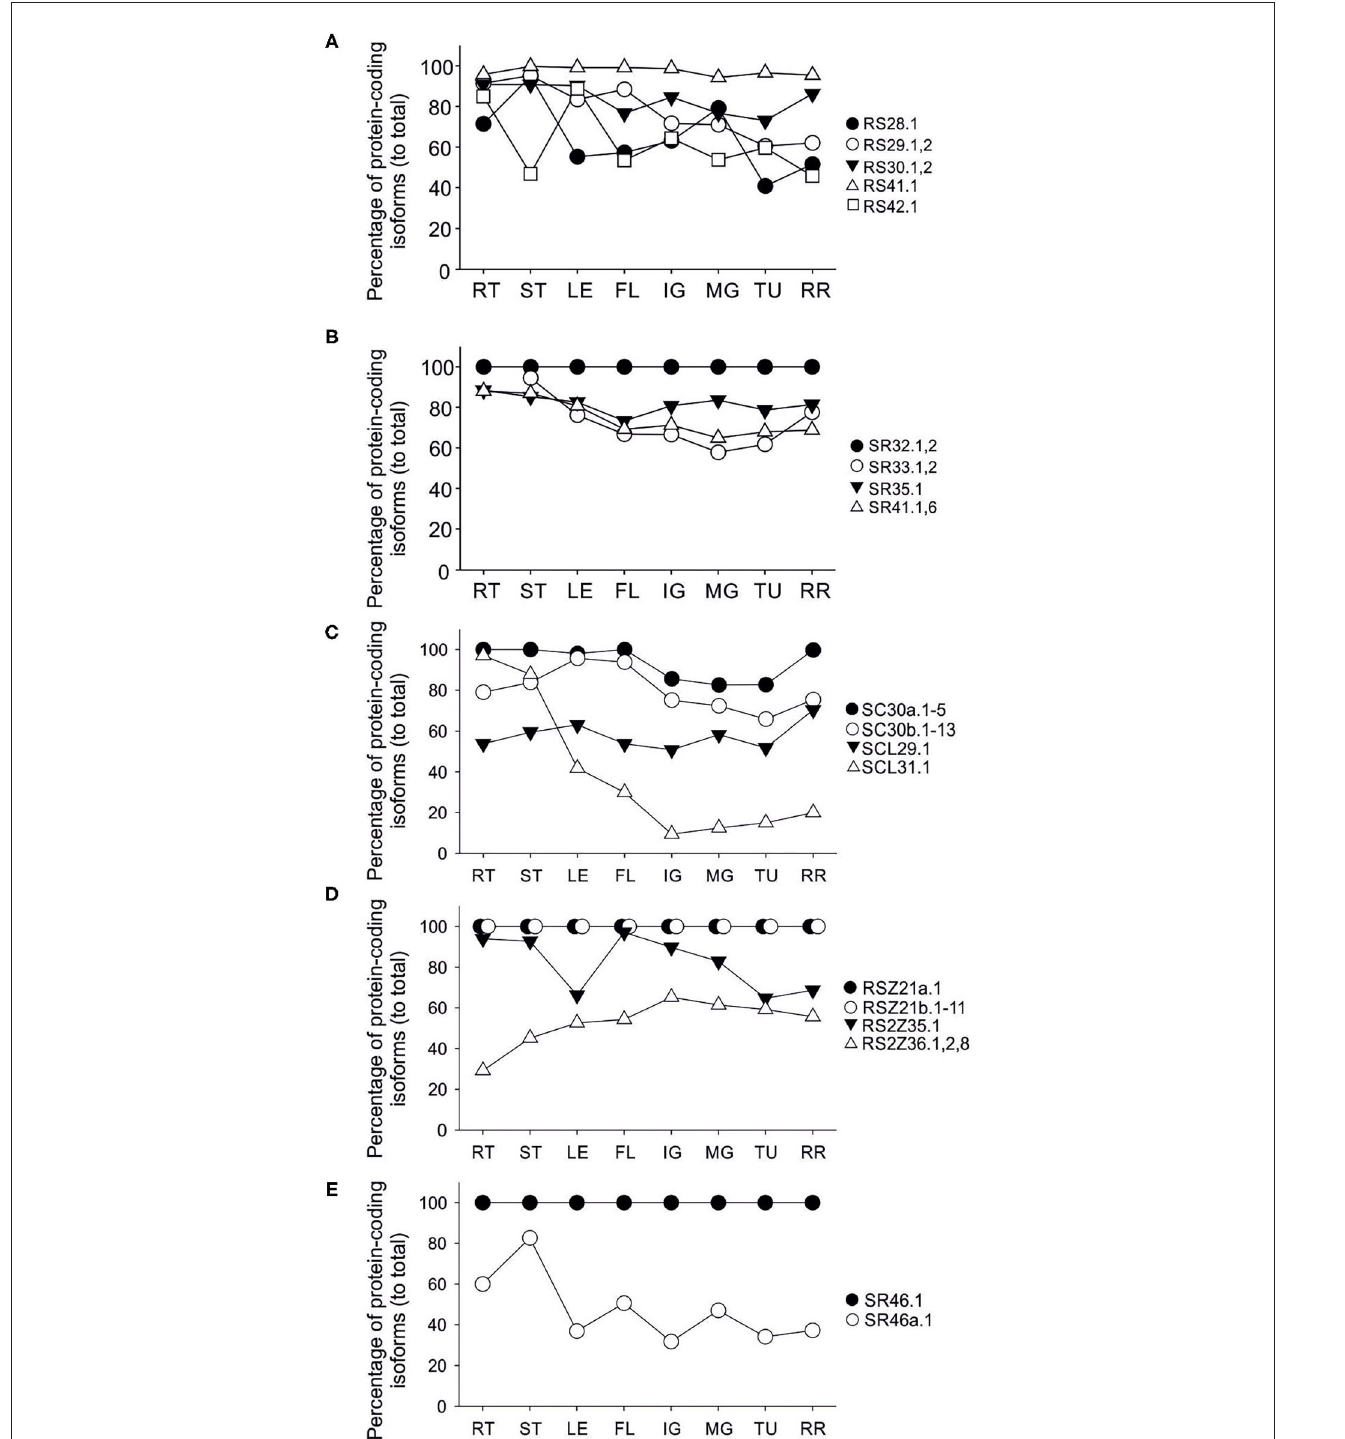
FIGURE 5 | Transcript levels of protein-coding isoforms of SR and SR-like genes in tomato tissues. The average of relative transcript levels of protein-coding isoforms of indicated genes in root (RT), stem (ST), leaf (LE), flower (FL), and in fruit stages immature green (IG), mature green (MG), turning (TU) and red ripe (RR) are shown. Transcripts were analyzed by RT-PCR using oligonucleotides flanking the sites of alternative splicing within the open reading frame ( Supplementary Figure 3 ) and quantified by densitometry using ImageJ 1.53 (Schindelin et al., 2012) after agarose gel electrophoresis and ethidium bromide staining. (A) RS, (B) SR, (C) SC and SCL, (D) RSZ and RS2Z, (E) SR-like